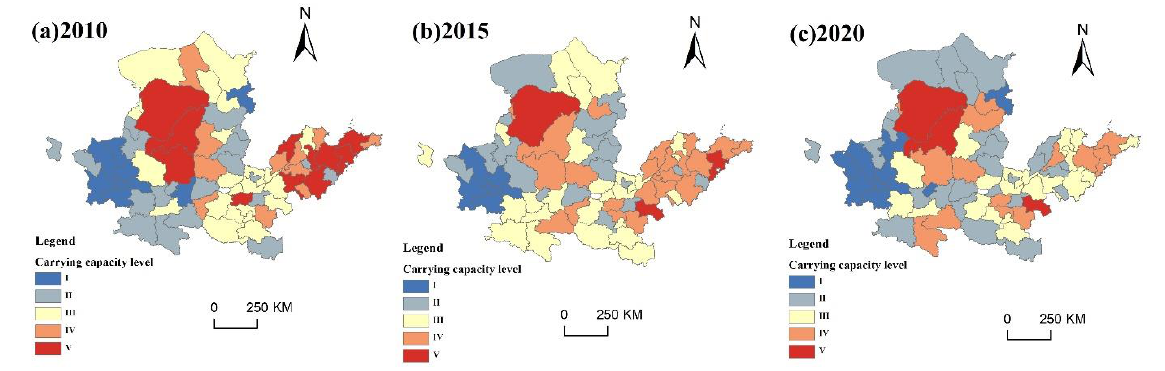
Figure 5. Spatial and temporal patterns of production capacity from 2010 to 2020.